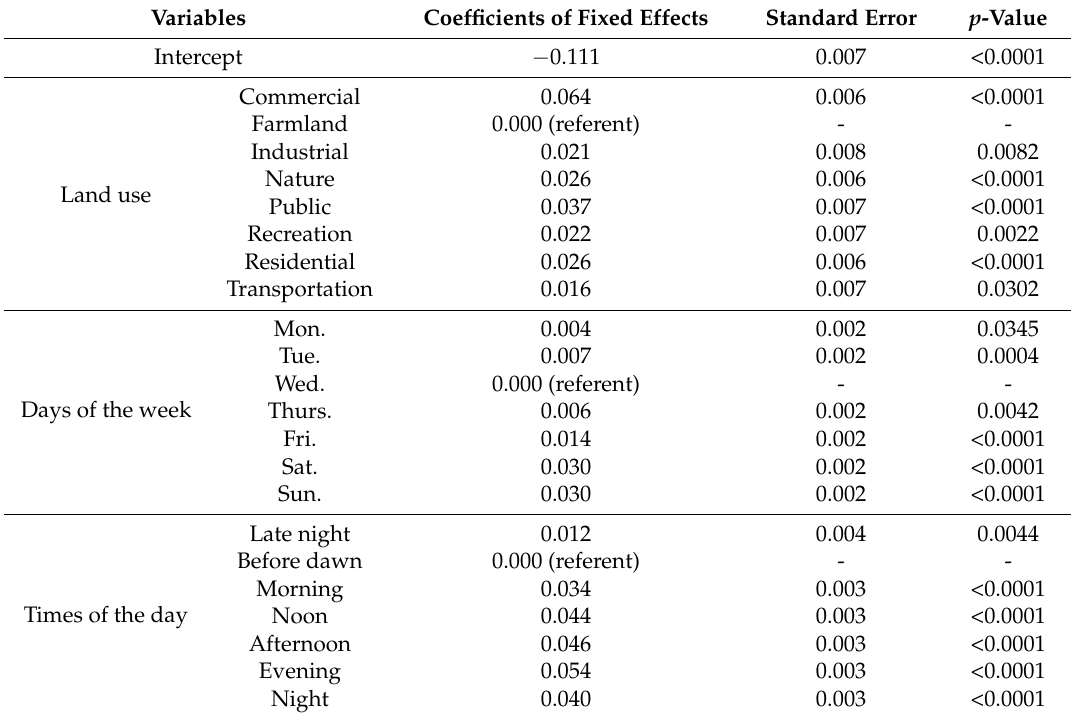
Table 2. Summary of fixed effect estimates on sentiment